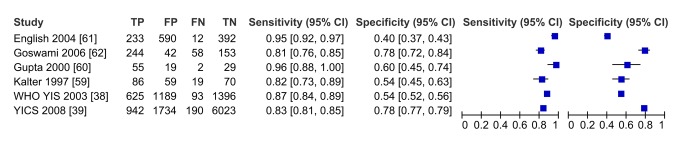
Forest plot of studies of diagnostic accuracy of clinical sign (IMCI) algorithms to detect severe disease/pBI in young infants compared to physician-laboratory diagnosis.